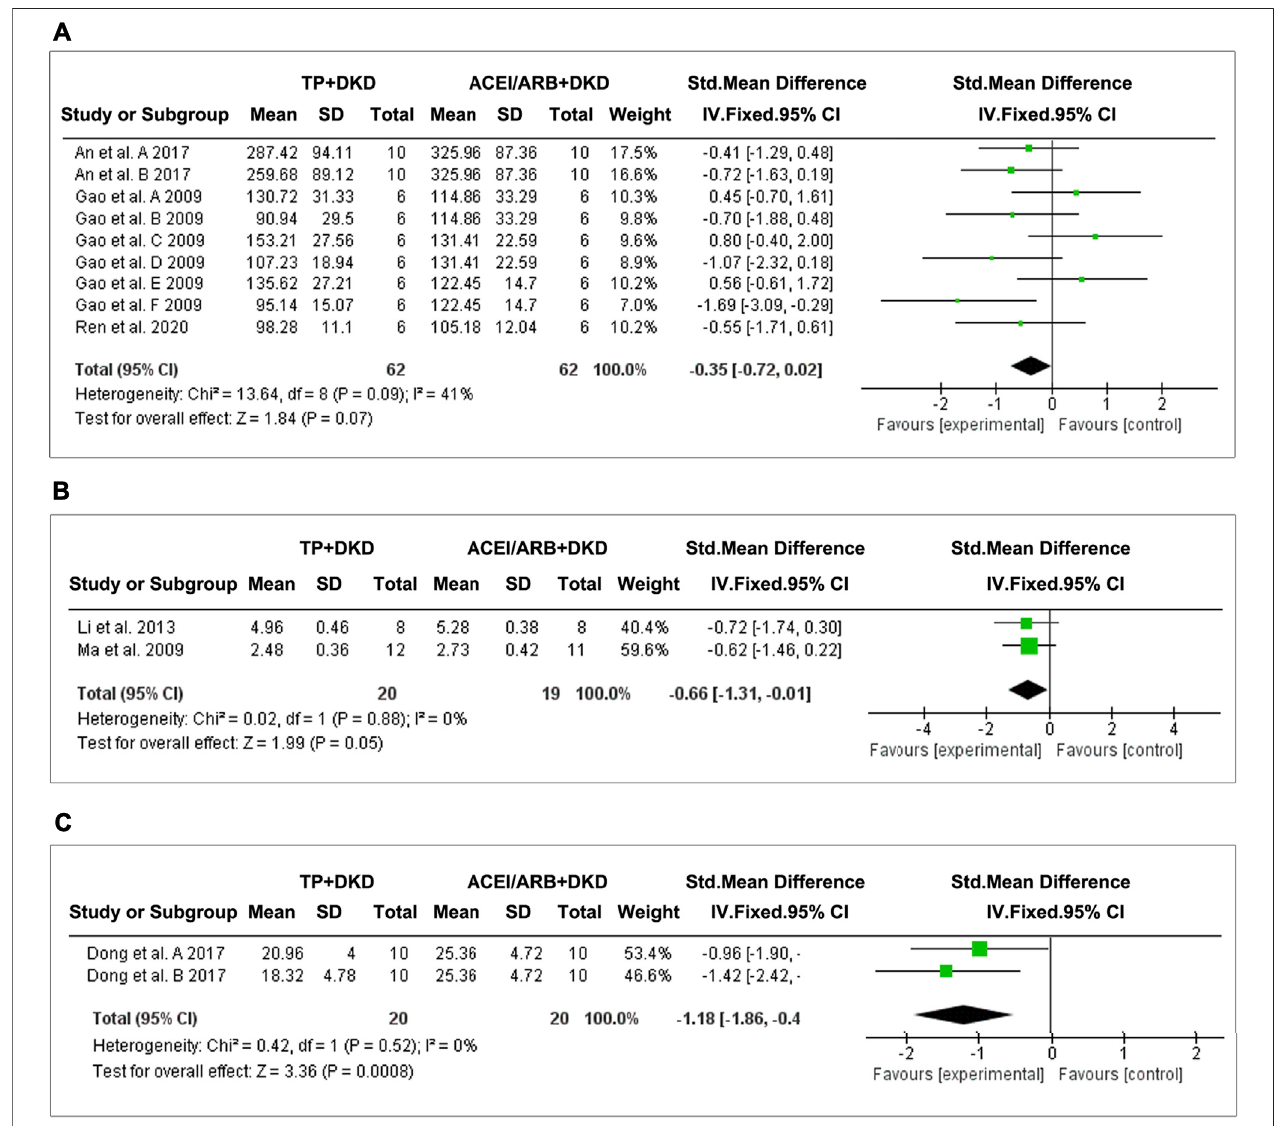
FIGURE 9 | Forest plot of (A) albuminuria, (B) UACR, and (C) total proteinuria outcome comparing with RAS inhibitor.